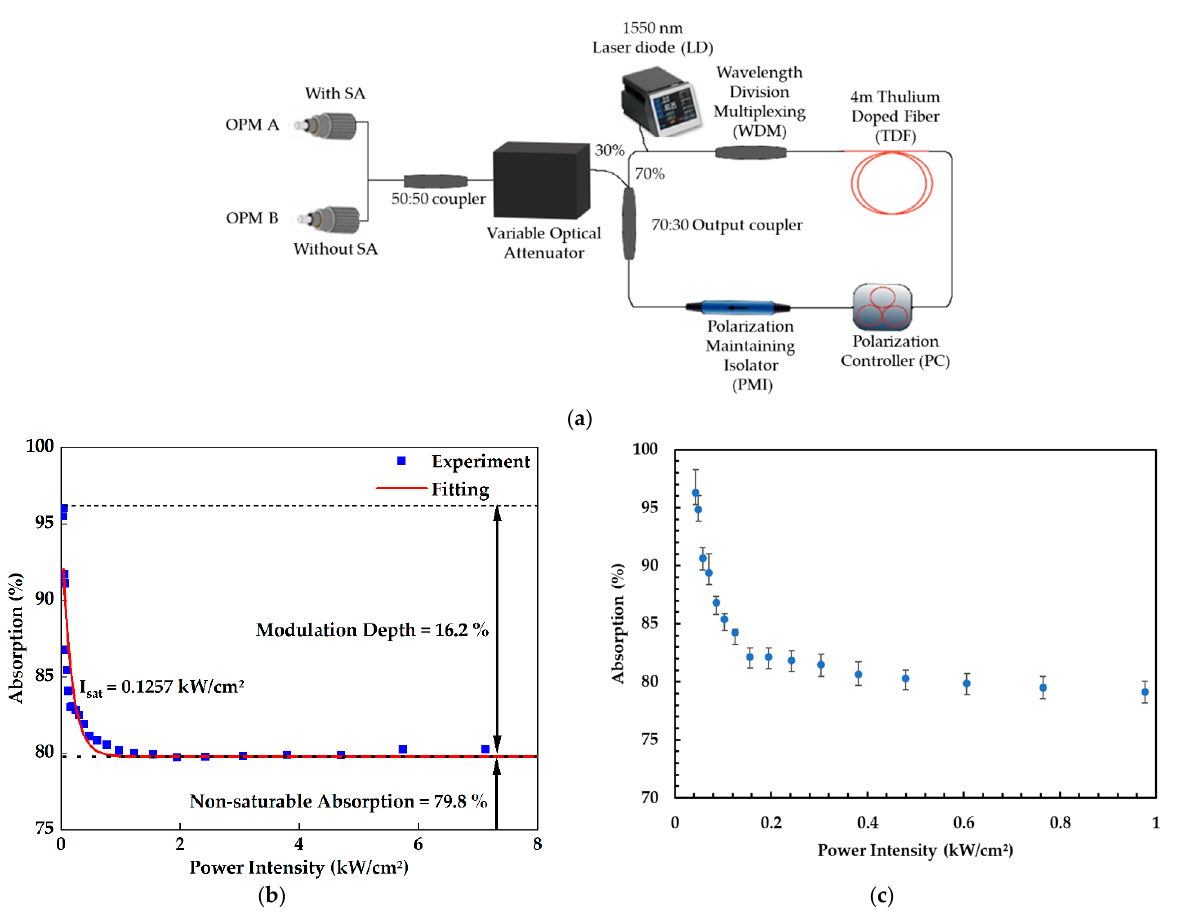
Figure 4. ( a ) Schematic diagram of power-dependent absorption measurement. ( b ) Non-linear optical absorption for CNT-chitin film. ( c ) Error bars for CNT-chitin film non-linear optical absorption experimental data.